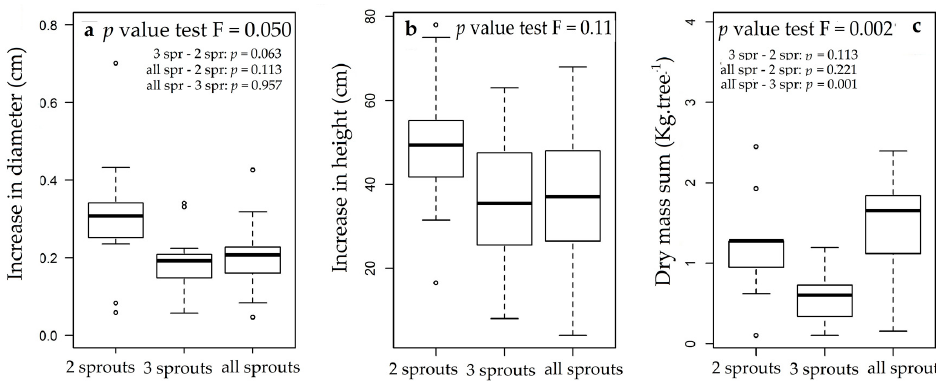
Figure A7. Sum of nutrients exported by the sequential management of whole trees and pruning 100% of the canopy in two commercial plantations in Maués, AM. ( a ) Nitrogen; ( b ) Phosphorus; ( c ) Potassium; ( d ) Calcium; ( e ) Magnesium; ( f ) Fe; ( g ) Zinc; ( h ) Manganese.